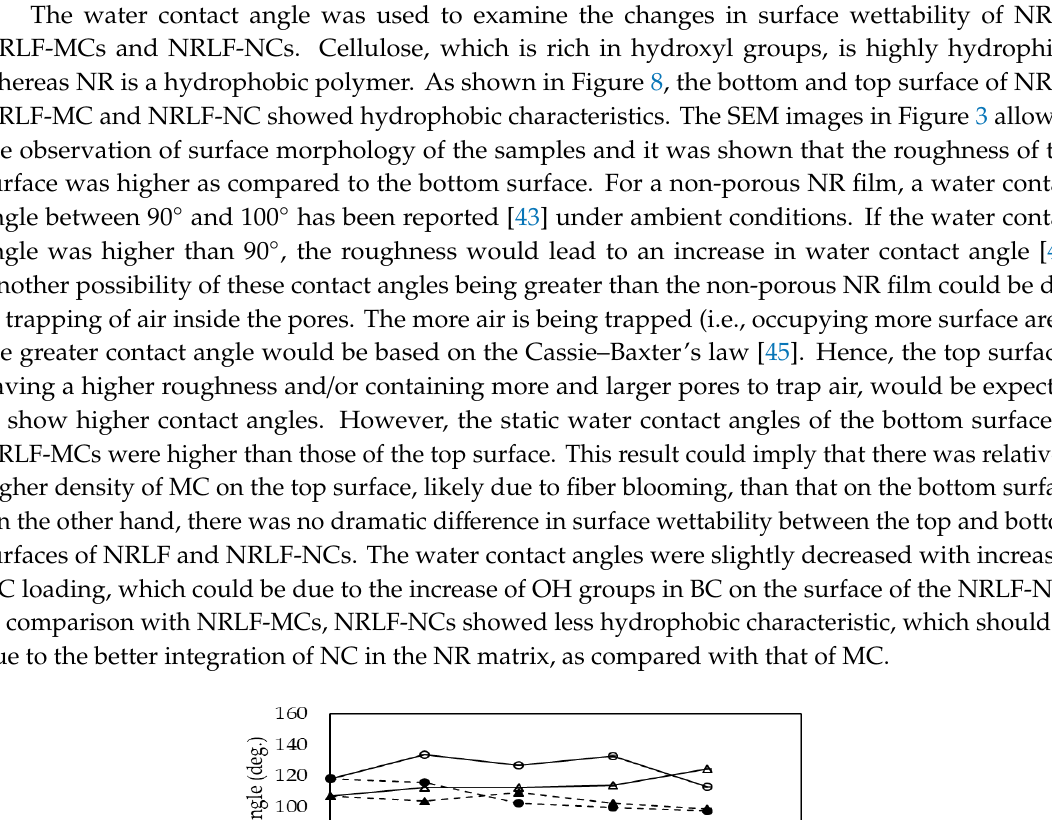
Figure 9. Water uptakes of NRLF, NRLF-MC and NRLF-NC. 403